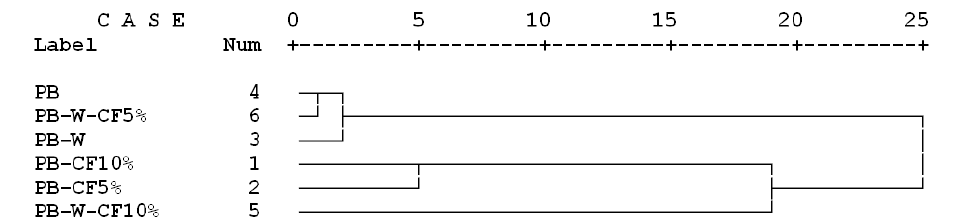
Figure 6. Cluster analysis of the six types of particleboard panels made from wood chips and chicken feathers and containing 10% wollastonite, based on the five fire properties (PB = particleboard; W = wollastonite; CF = chicken feather content).